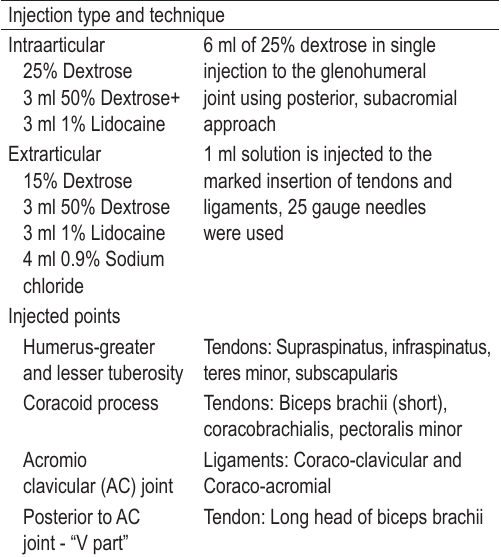
TABLE 1. Prolotherapy solution and injection points Injection type and technique Intraarticular